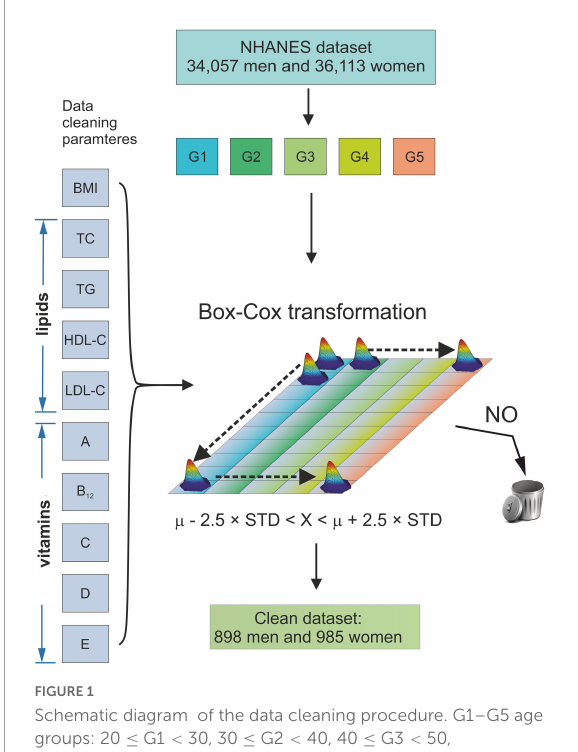
FIGURE1 Schematic diagram of the data cleaning procedure. G1–G5 age groups: 20 ≤ G1 < 30, 30 ≤ G2 < 40, 40 ≤ G3 < 50, 50 ≤ G4 < 60, and 60 ≤ G5 < 70 years of age. BMI, Body Mass Index; TC, Total Cholesterol; TG, Triglycerides; HDL-C, High-Density Lipoprotein Cholesterol; LDL, Low-Density Lipoprotein Cholesterol; A, vitamin A; B12, vitamin B12; C, vitamin C; D, vitamin D; E, vitamin E; µ , mean of a sample; STD, standard deviation of a